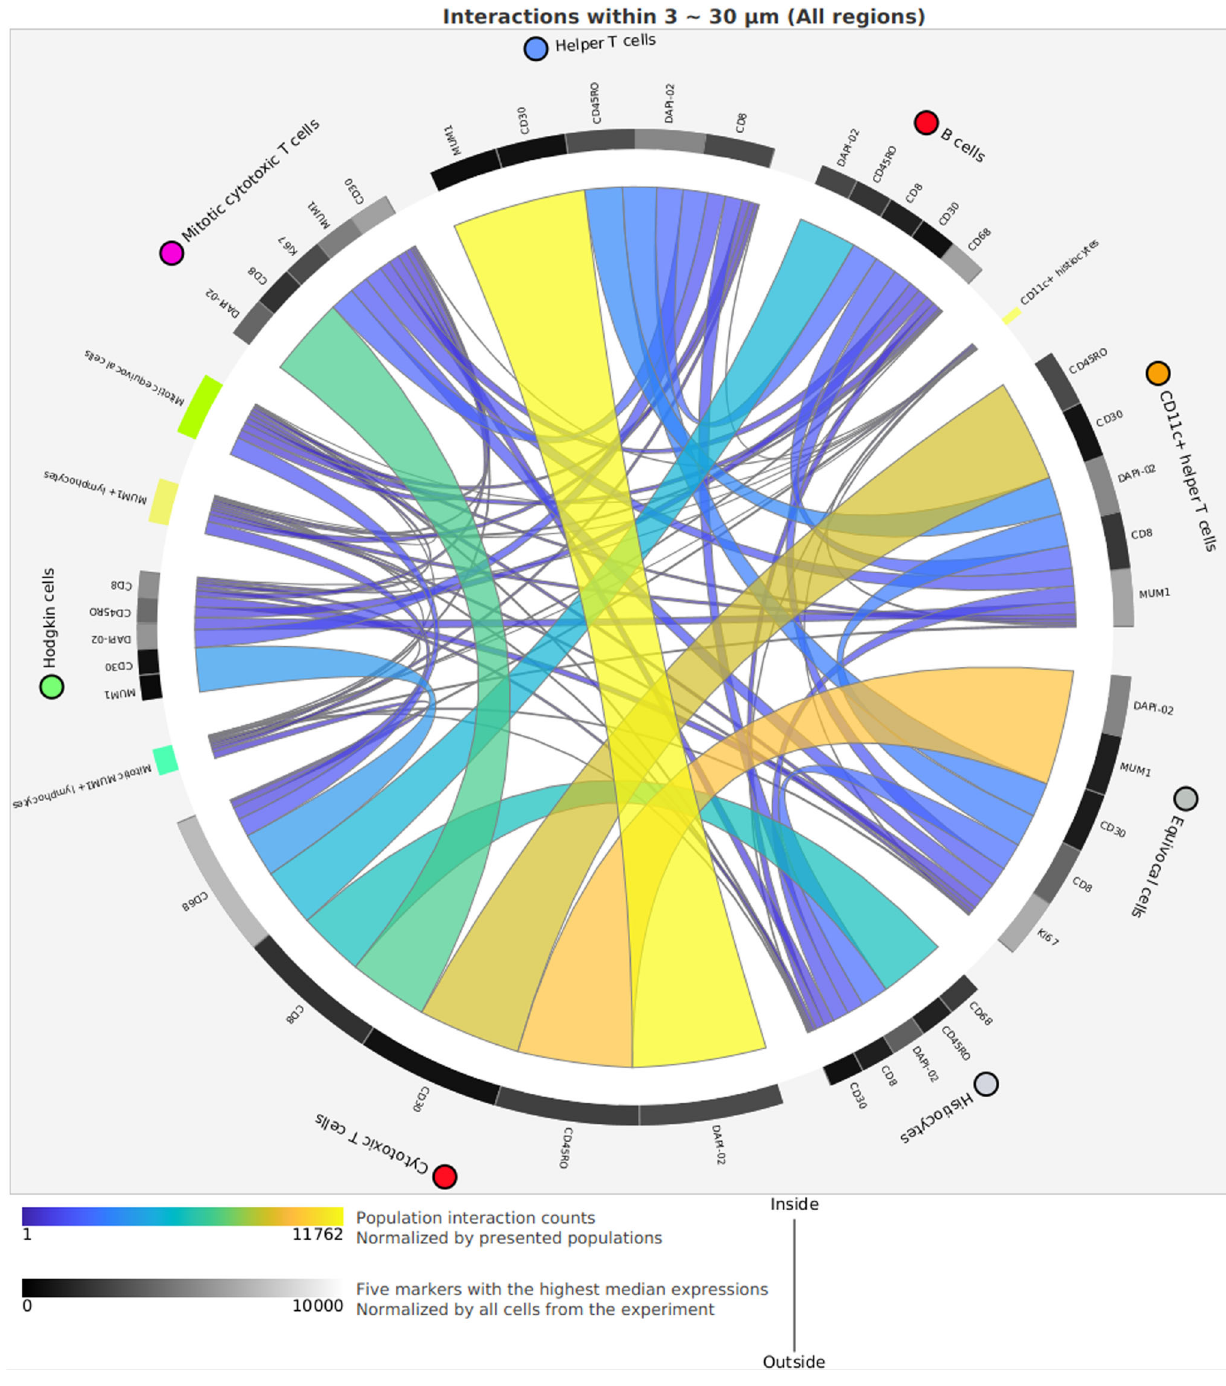
Fig. 6 Circos plot of spatial analysis of nearby cells in the example case of classic Hodgkin lymphoma. The Circos plot was created using the CODEX MAV plugin (Akoya Biosciences) for ImageJ, using both of the imaged regions. DAPI-02 refers to DAPI signal in the second CODEX imaging cycle. The fi ve markers with highest median expressions is somewhat misleading since the scale of the intensities of the various markers differ signi fi cantly (compare with Fig.